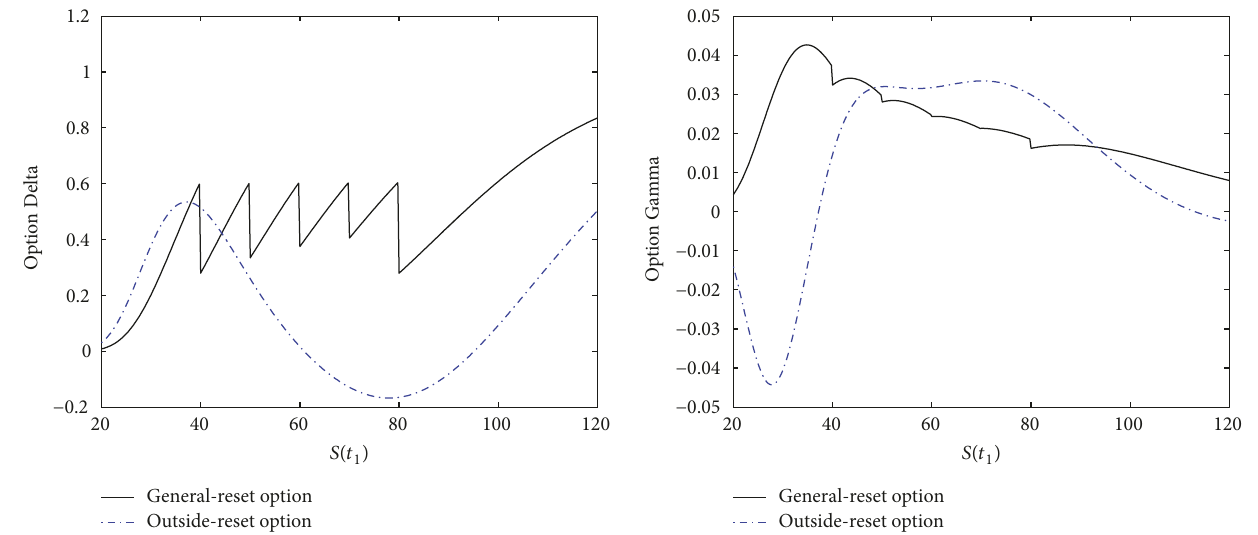
Figure 4: Comparison of option Δ and Γ between the general-reset option and outside-reset